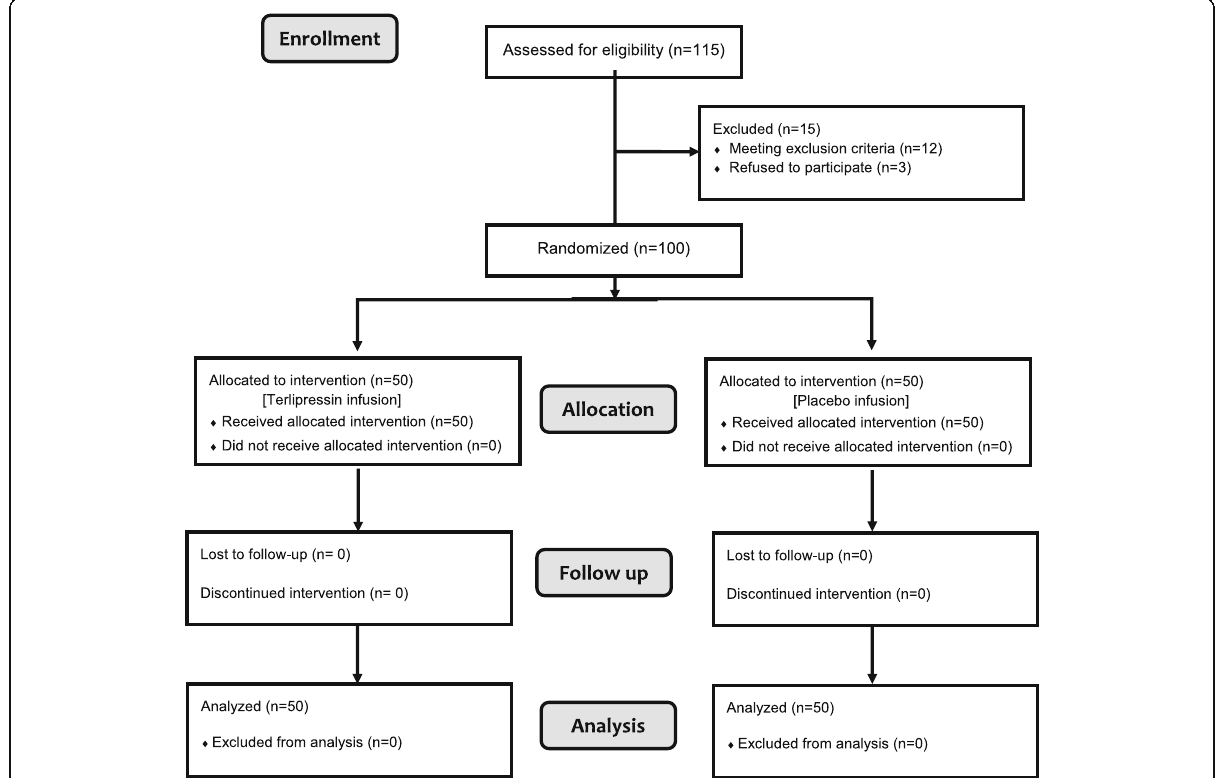
Fig. 1 CONSORT flow diagram showing the flow of patients ’ participation through each stage of the